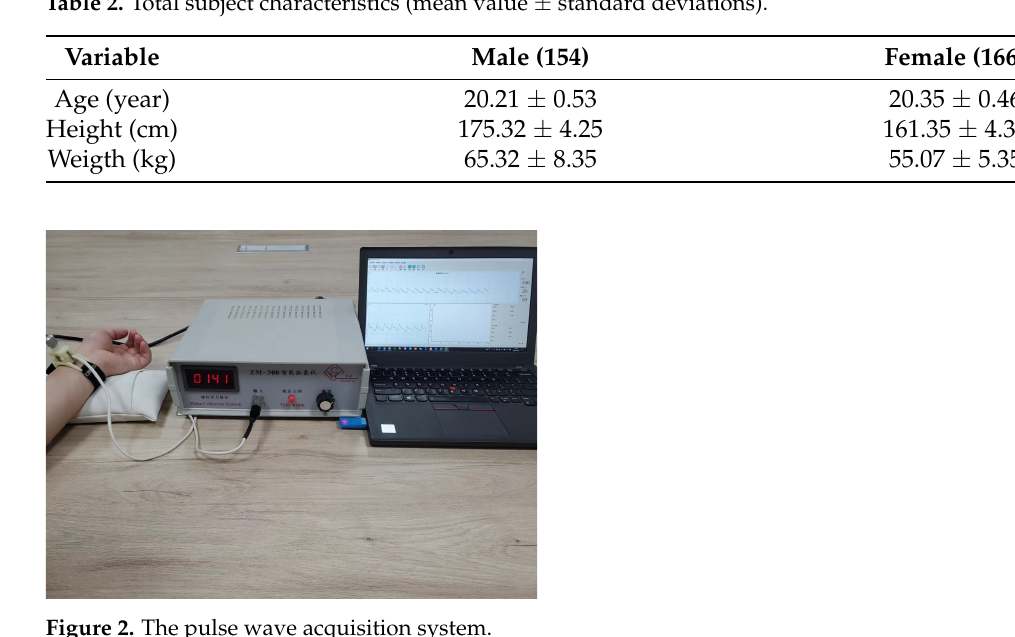
Table 2. Total subject characteristics (mean value ± standard deviations).